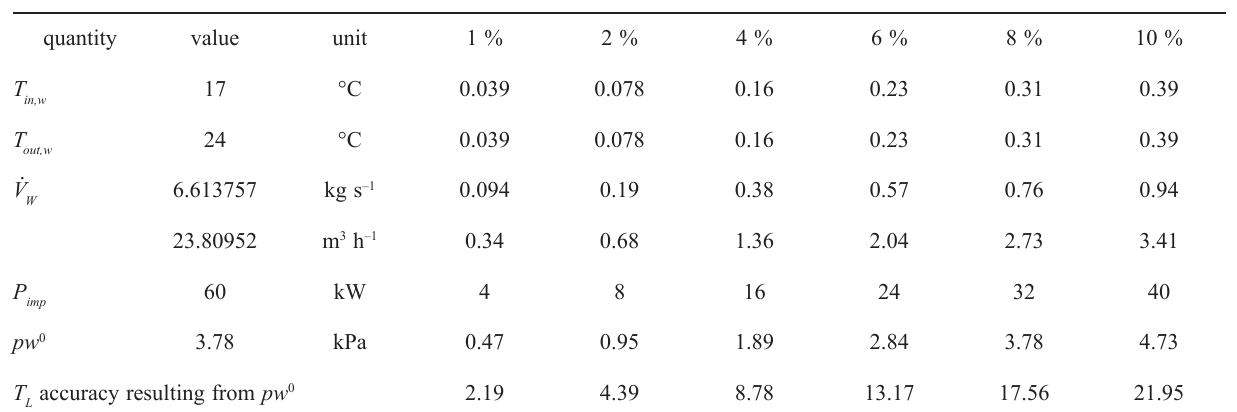
Table 1 – Accuracies of individual process variables contributing to the overall relative error of the software biocalorimetry-based sensor as obtained by the parametric study